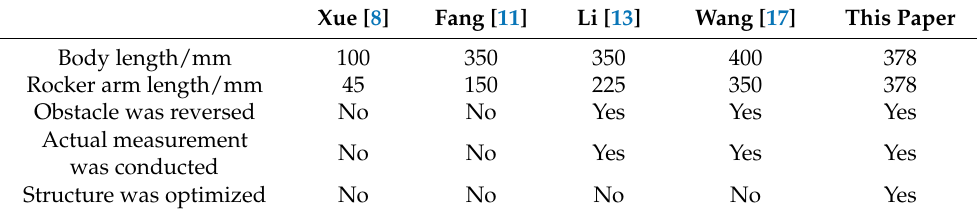
Table 2. Comparison of our four-track twin-rocker robot with similar